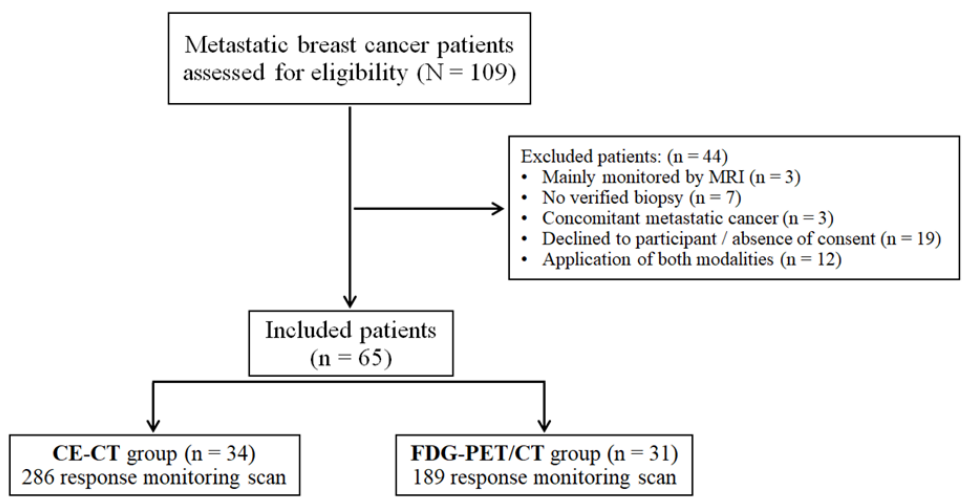
Figure 1. Patient flowchart and distribution of the included patients to study groups (CE-CT: contrast-enhanced computed tomography; FDG-PET/CT: Fluorodeoxyglucose positron emission tomography with integrated computed tomography; MRI: magnetic resonance imaging).